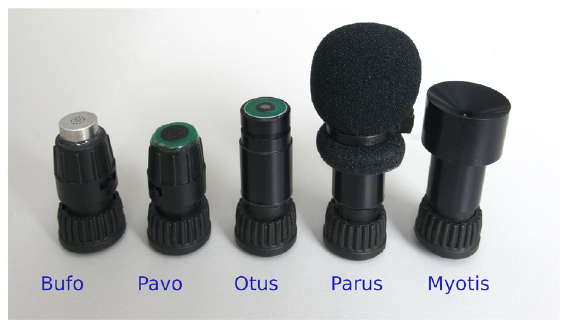
Figure 8. The current Sonitor microphone models. Note that the Bufo does not have a protective vent on this photograph. The Parus has a windscreen attached with a cable tie, and the Myotis is depicted with the ultrasonic horn.